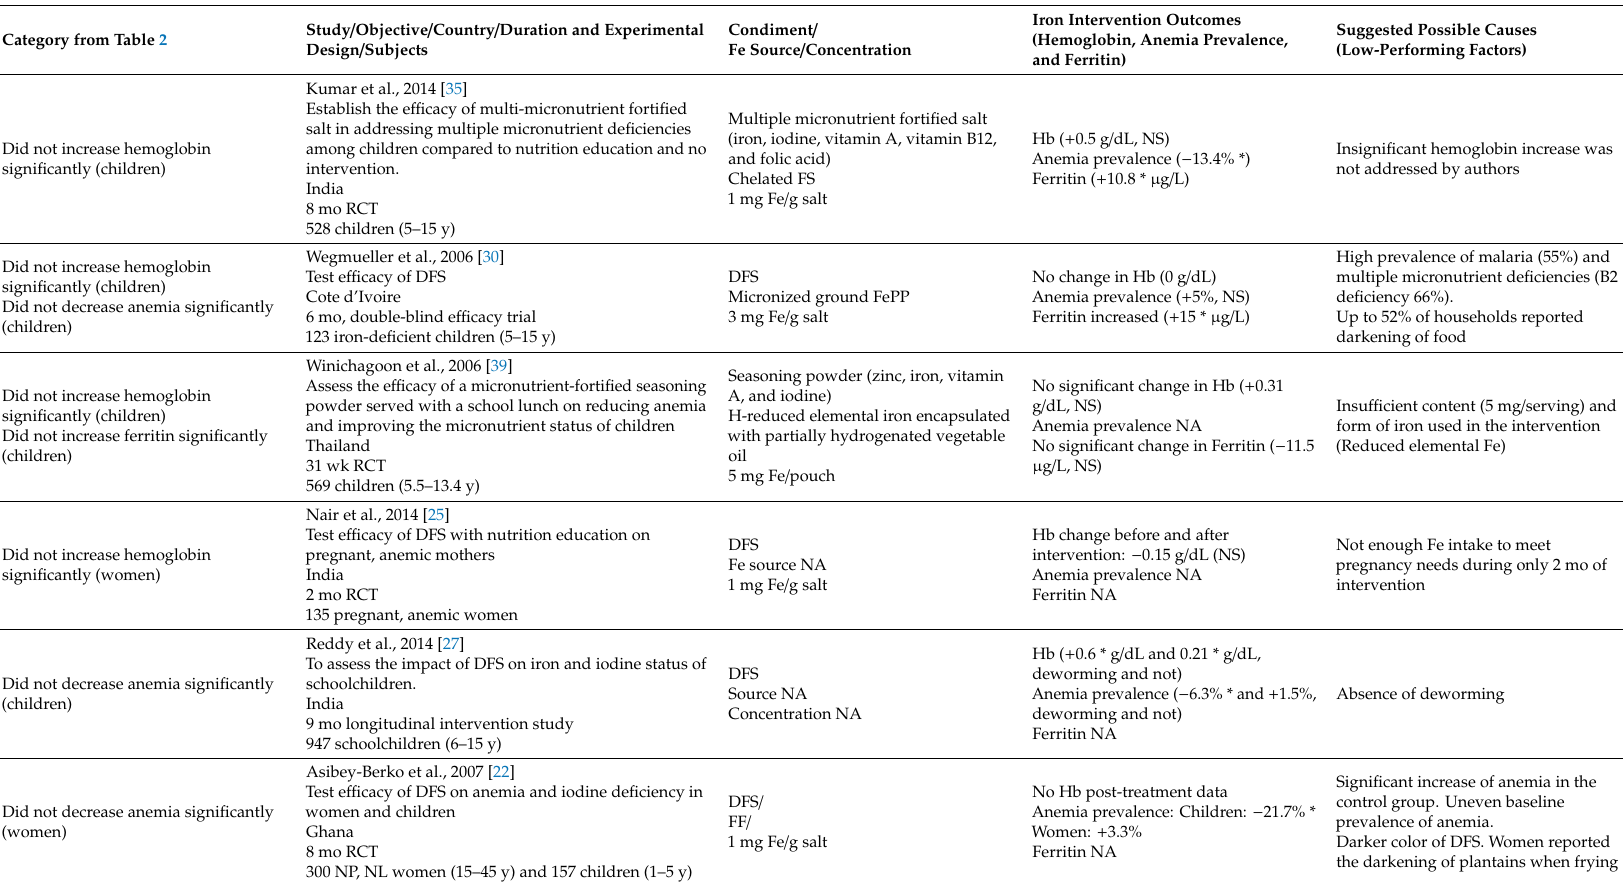
Table 3. Low-performing studies of the e ffi cacy of iron fortification of condiments. Impact on hemoglobin, anemia, and iron status. Category from Table 2